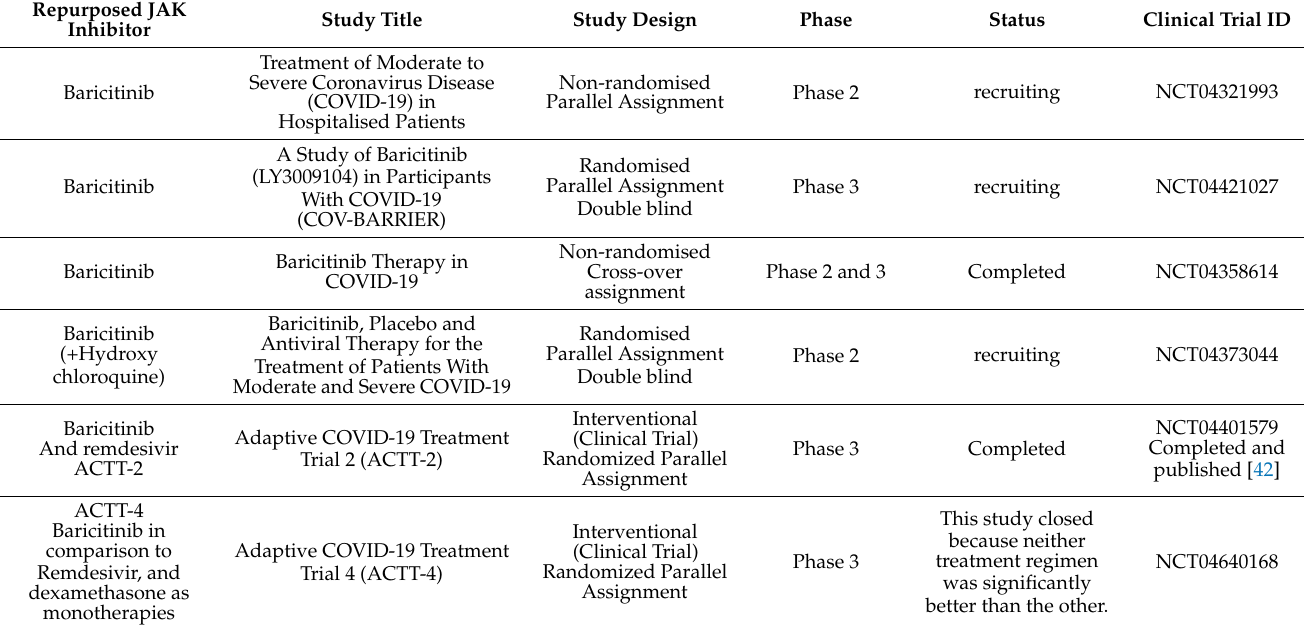
Table 2. Clinical trials on baricitinib as a therapy for